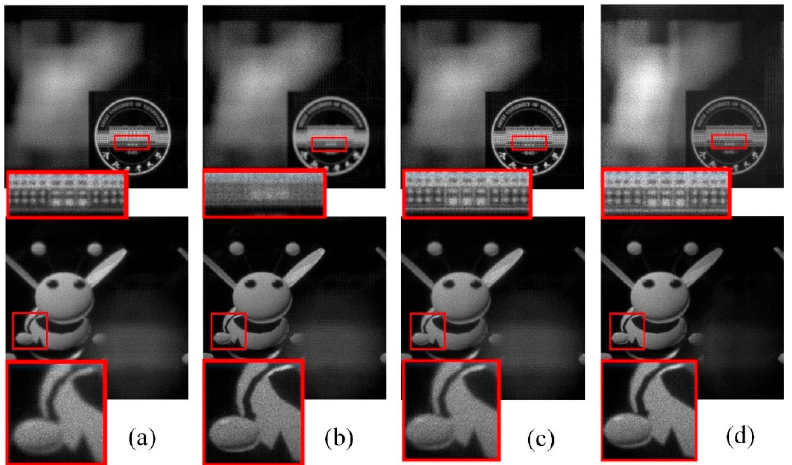
Figure 8. ( a ) Numerical simulation results with pixel size Δ x 1 = 5 μ m. ( b ) Numerical simulation results with pixel size Δ x 1 = 2.5 μ m. ( c ) Numerical simulation results with pixel size Δ x 1 = 2.5 μ m and aperture filtering. ( d ) Numerical simulation results with pixel size Δ x 1 = 2.5 μ m and partial aperture filtering.